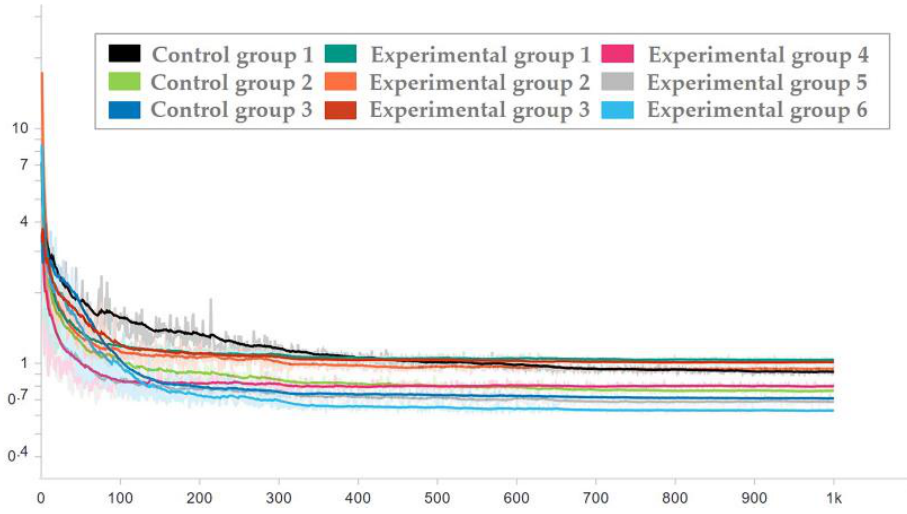
Figure 16. Loss trend of the test set with random seed 0.